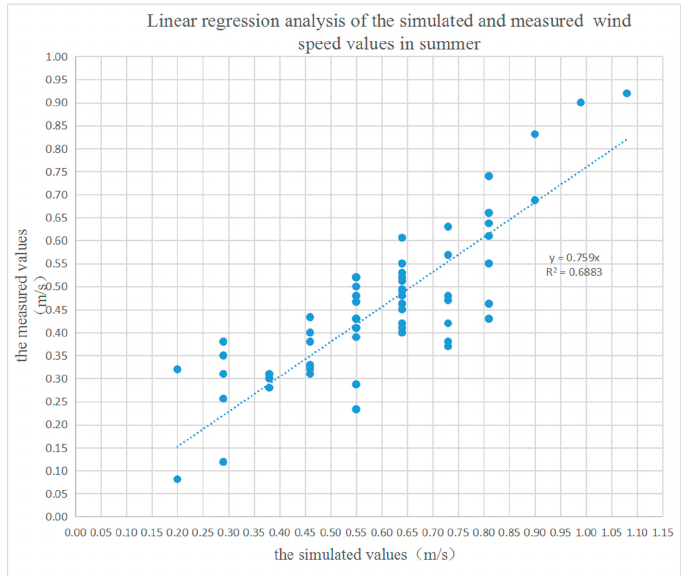
Figure 6. Linear regression of the wind speed simulated and measured values of Prince Kung’s Mansion (Fengshui layout).